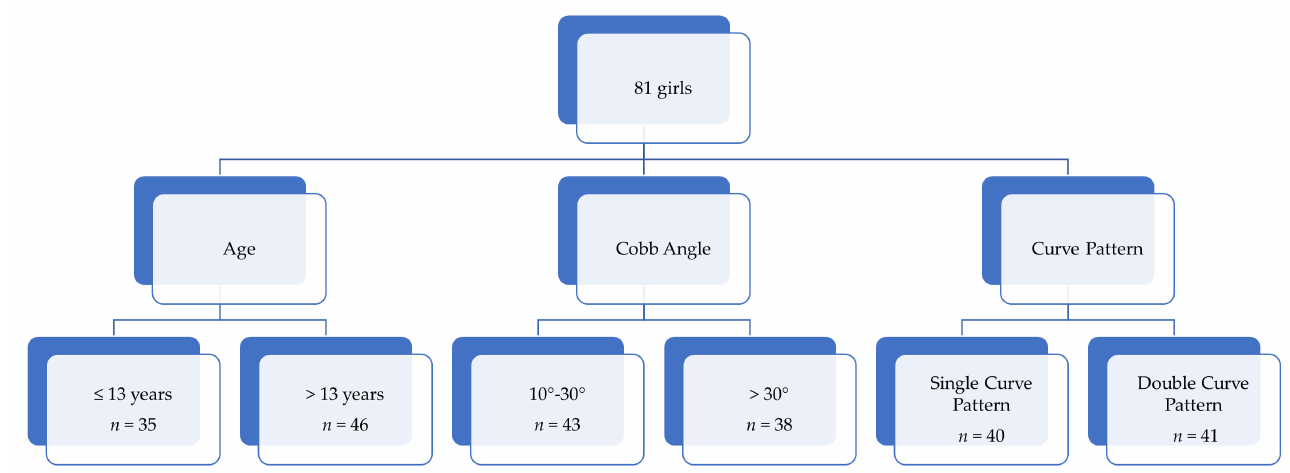
Figure 1. Patients’ distribution according to age, Cobb angle, and curve